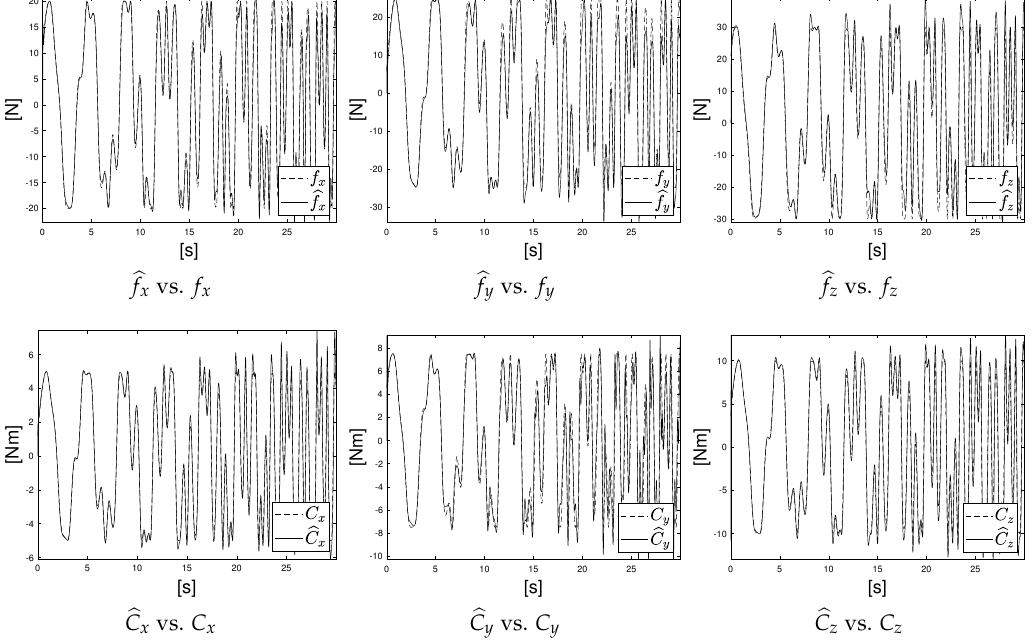
Figure 3. Estimated interaction forces (cid:98) f and torques (cid:98) C (continuous line) vs. real interaction forces f and torques C (dashed line) for the #2 simulation scenario.